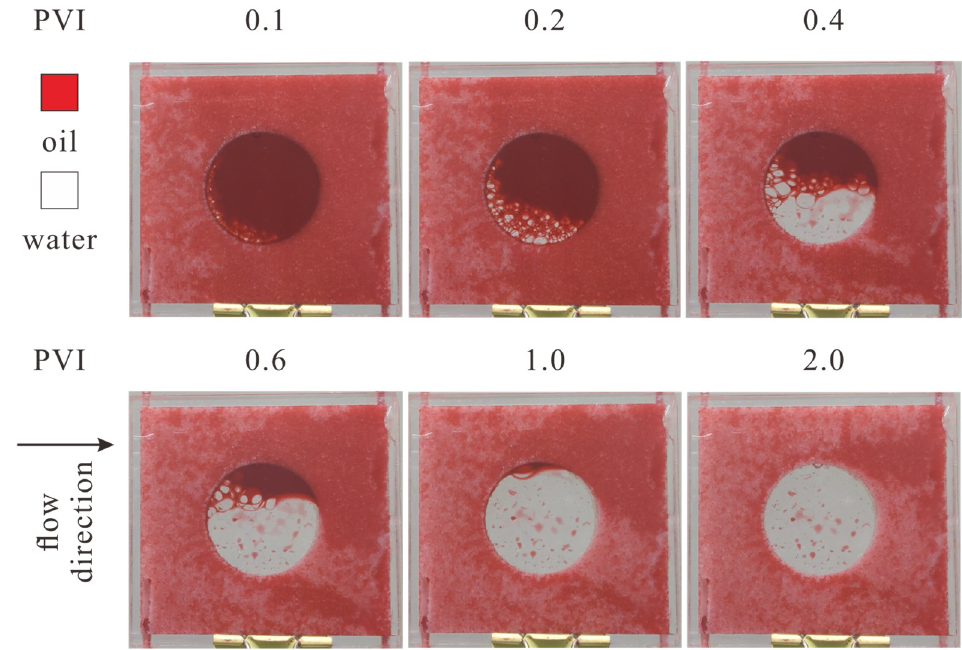
Figure 7. Oil saturation distribution in the single-vug model during experiments with θ = 0°.